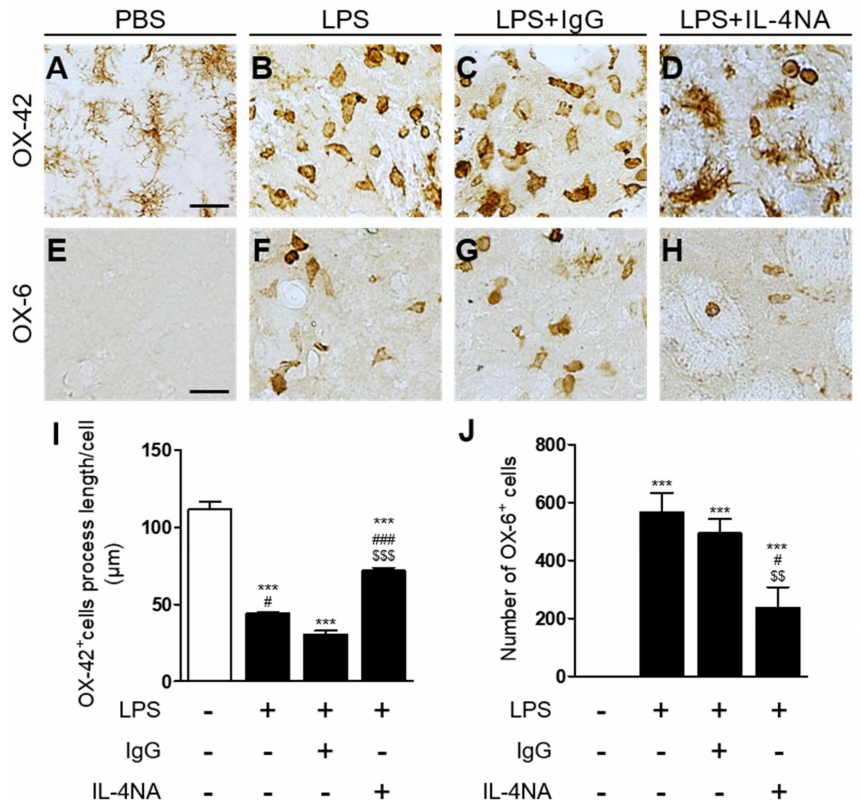
Figure 4. IL-4 contributes to microglial activation in the LPS-injected striatum in vivo. Animals intrastriatally received a unilateral injection of PBS ( A , E ) as a control, LPS ( B , F ), LPS+non-specific IgG (1 µ g/ µ L; ( C , G )), and LPS+IL-4NA (1 µ g/ µ L; ( D , H )). At 3 days after injection, animals were transcardially perfused and brain tissues were processed for OX-42 immunostaining ( A – D ) or OX-6 ( E – H ) immunostaining at 3 days post LPS. ( I ) Quantification of OX-42 process length. *** p < 0.001, significantly different from PBS (control). ### p < 0.001, significantly different from LPS. Mean ± SEM; n of animals = 4 to 5 in each group. ANOVA and Bonferroni analysis. ( J ) Number of OX-6 + cells in the LPS-injected striatum (total area = 4.6 × 10 5 µ m 2 ). *** p < 0.001 significantly different from PBS (control), # p < 0.01 significantly different from LPS mean ± SEM; n of animals = 4 to 5 in each group. ANOVA and Bonferroni analysis. # p < 0.05, significantly different from LPS. ### p < 0.001, significantly different from LPS+IgG. $$ p < 0.01, significantly different from LPS. $$$ p <